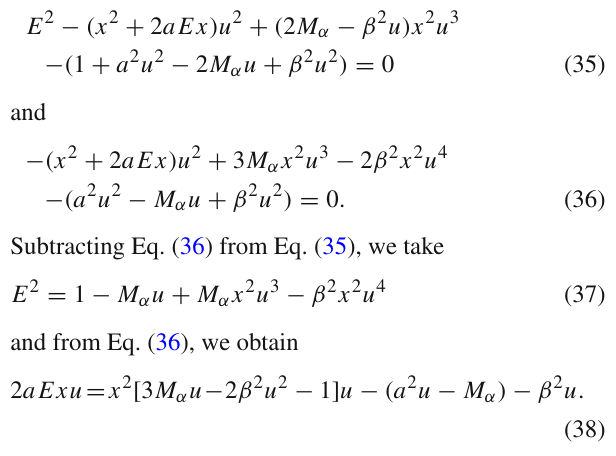
Fig. 7 r ps isphotosphereorphotoncircularorbitoftheSchwarzschild- MOGblackholeand r c isthephotoncircularorbitofaKerr-MOGblack hole when a = 0. For the two cases, the solutions coincide for all values of